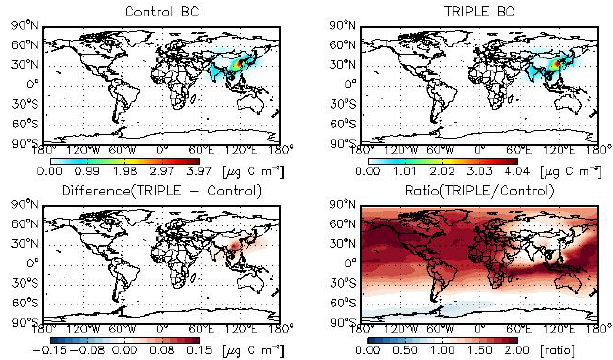
Fig. 10. Vertical profiles of BC and OC from model simulations and aircraft campaigns. (a) BC from NSF/NCAR C-130 aircraft cam- paign in ACE-Asia (latitude 25–45 ◦ N); (b) OC from NSF/NCAR C-130 aircraft campaign in ACE-Asia (latitude 25–45 ◦ N); (c) BC from NSF/NCAR GV in HIPPO1 (latitude 20–60 ◦ S); (d) BC from NSF/NCAR GV in HIPPO1 (latitude 60–67 ◦ S). Model and obser- vational data are averaged over 1km altitude bins. Simulation data is sampled along the track of both campaigns, with the same month of campaigns but in the year 2005 in terms of monthly mean value.